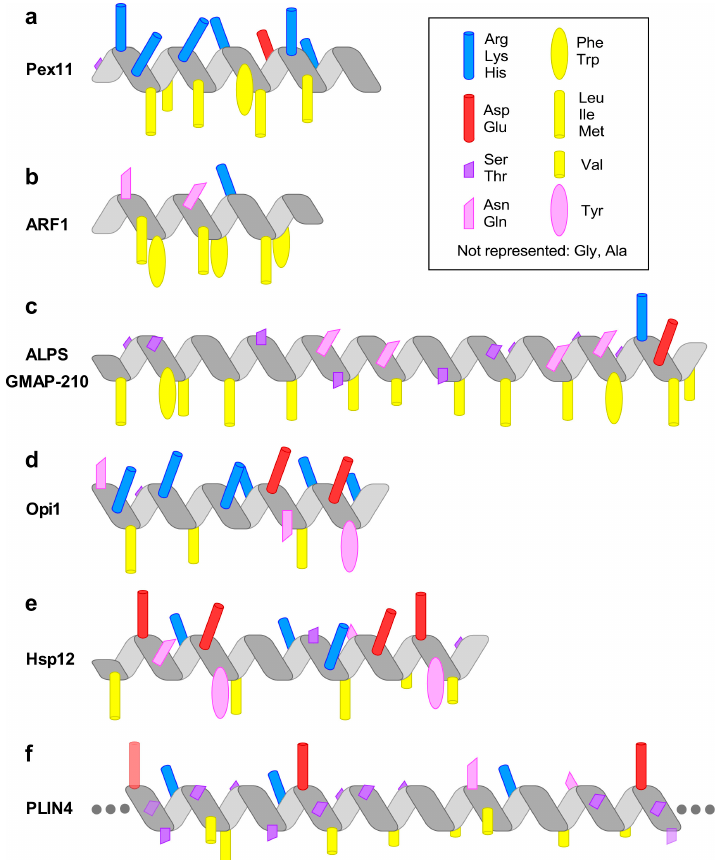
Figure 1. The chemical diversity of amphipathic helices (AHs). The diagrams highlight the most prominent chemical features of the AHs discussed in the text. ( a ) The AH of Pex11 has a highly basic polar face and a prominent hydrophobic face (amino-acids (aa) 66–83 of Penicillium chrysogenum Pex11). ( b ) The AH of the small G protein ARF1 contains two bulky hydrophobic residues per helical turn (aa 2–14, human protein). ( c ) The amphipathic lipid packing sensor (ALPS) motif of the golgin GMAP-210 contains one bulky hydrophobic residue per helical turn and is rich in Ser, Thr, and Gly in its polar face (aa 1–38, human protein). ( d ) The AH of Opi1 contains basic residues in its polar face, which have been proposed to bind preferentially to the negatively charged phosphatidic acid (PA) (aa 111–128, Saccharomyces cerevisiae protein). ( e ) The four AHs of heat-shock protein-12 (Hsp12) contain both positively and negatively charged residues. The positively charged residues form two wings at the polar/non-polar interface, whereas the negatively charged residues are concentrated in the center of the polar face. The longest helix, helix 4 (aa 74–97 in the S. cerevisiae protein), is shown. ( f ) Perilipin 4 (PLIN4) contains a giant and highly repetitive AH of about 1000 aa. The drawing schematizes the chemistry of a single human 33-mer repeat. Large hydrophobic residues are absent from this AH. Instead, the hydrophobic face is rich in Ala, Val, and Thr residues. The polar face contains both positively and negatively charged residues, with the positive charge concentrated on one side of the AH.